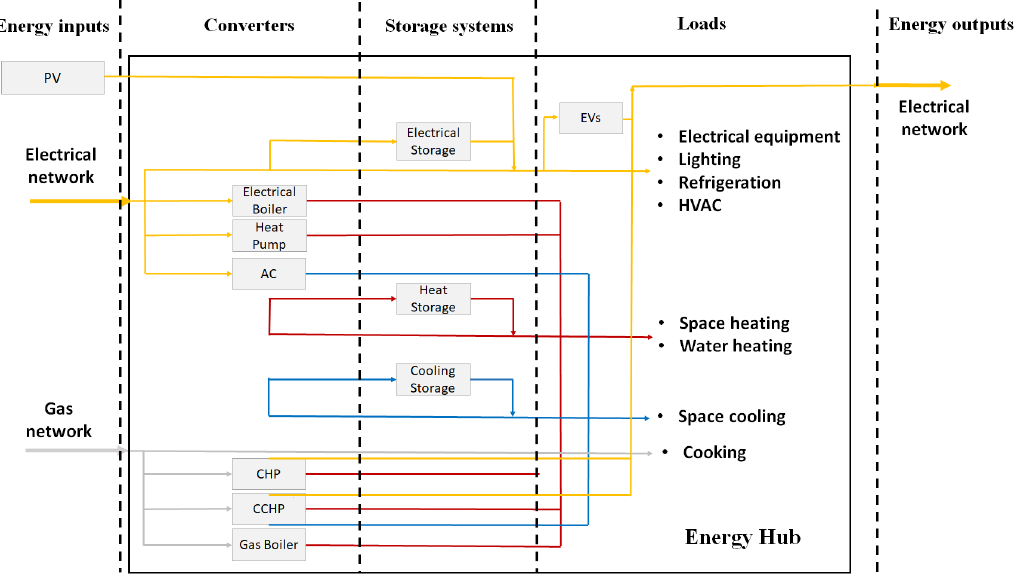
Figure 1. Example of an energy hub